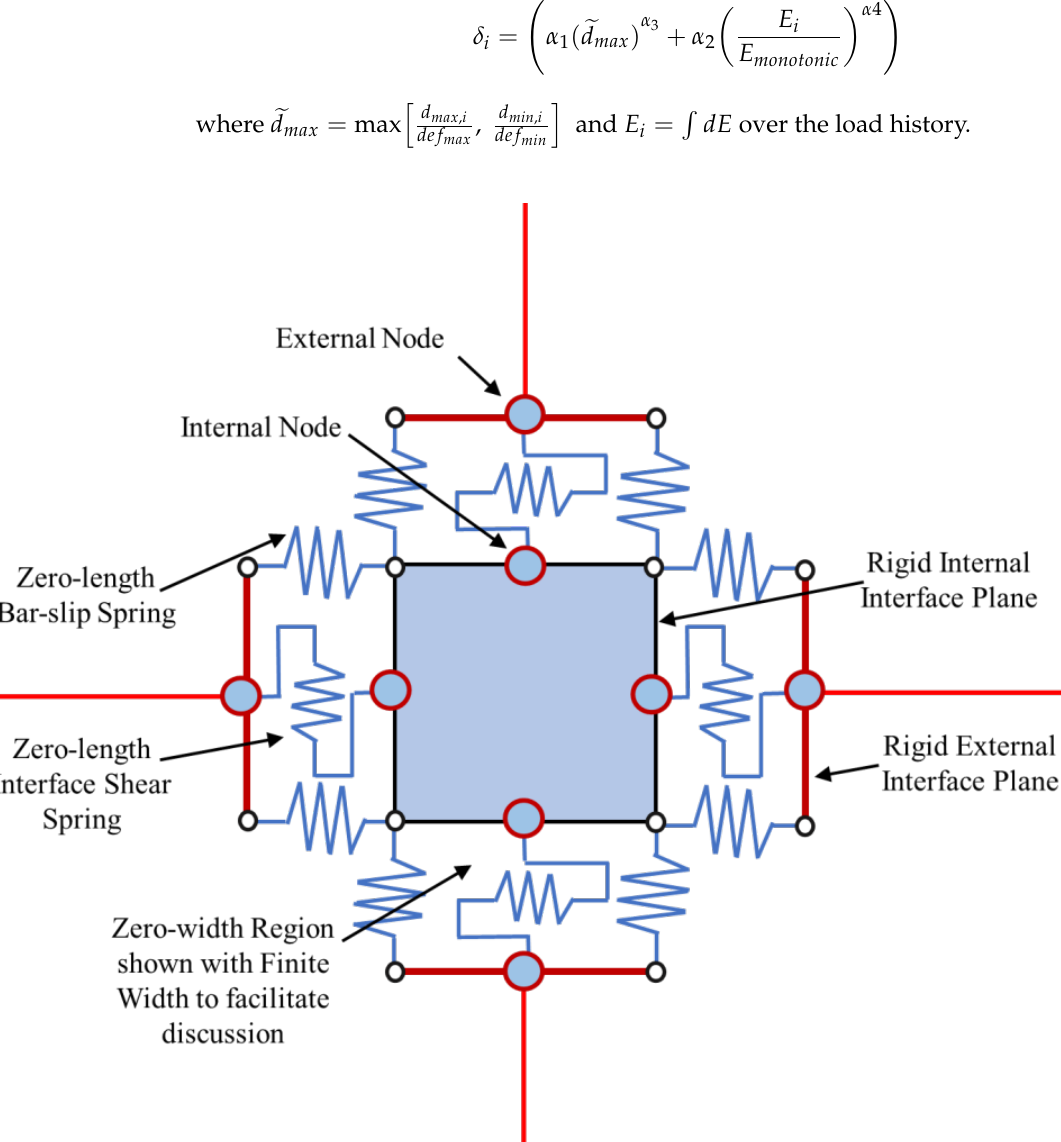
Figure 9. Beam – column joint with zero-length interface shear and bar – slip springs and shear panel, Figure 9. Beam–column joint with zero-length interface shear and bar–slip springs and shear panel, reproduced from literature [47]. reproduced from literature